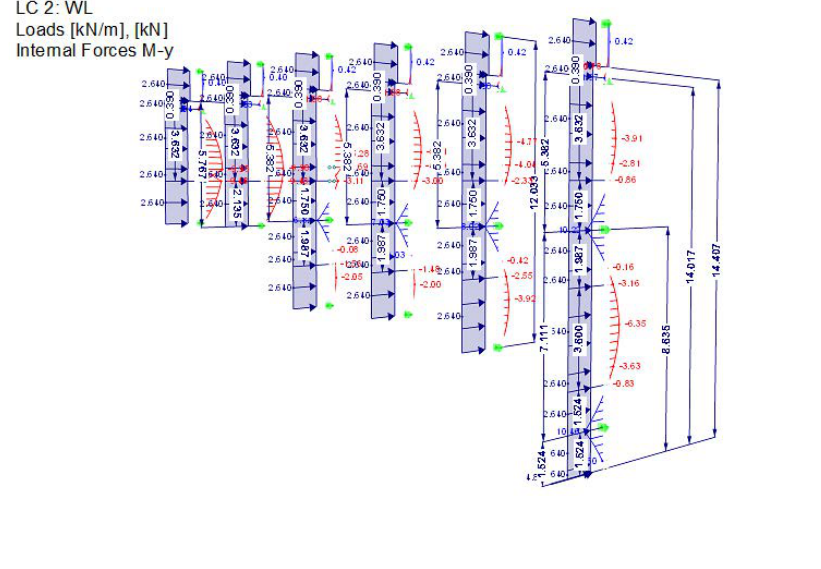
Fig. 5 Analytical model of glass